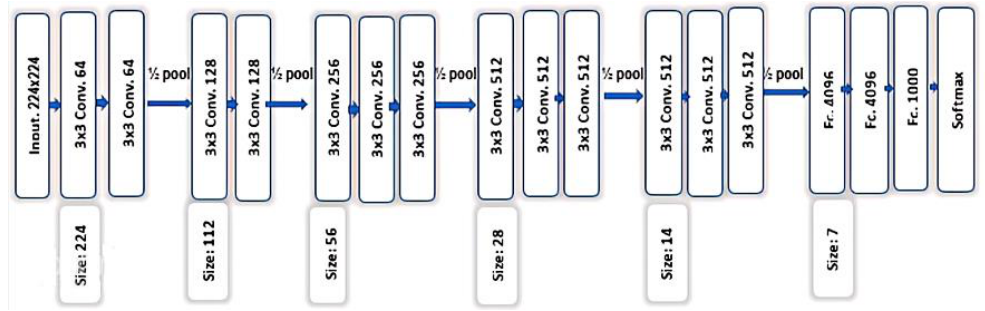
Figure 9. VGG-16 architecture.